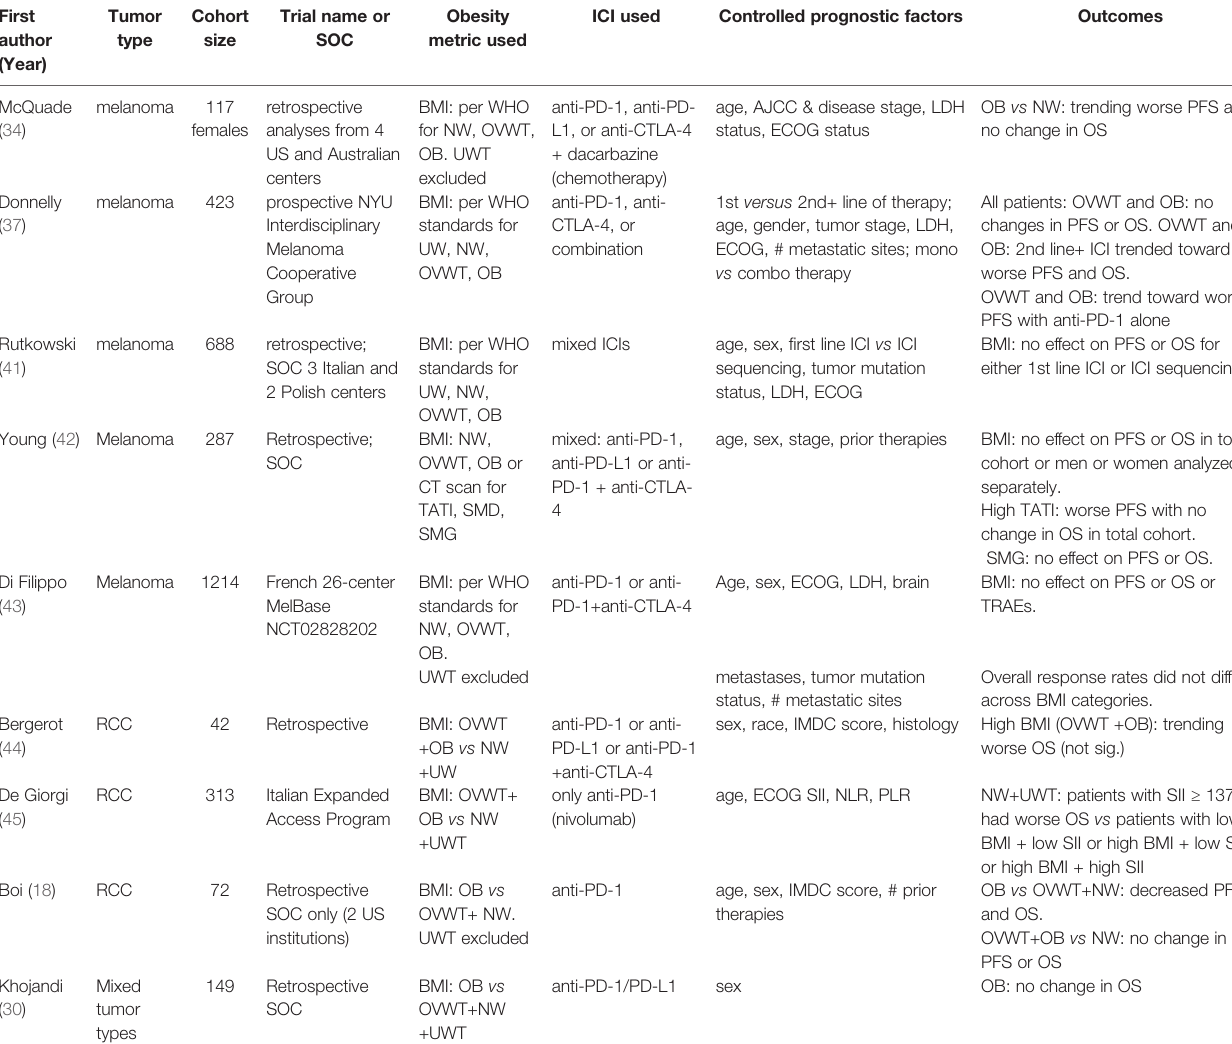
TABLE 2 | Studies refuting the obesity paradox for cancer immunotherapy